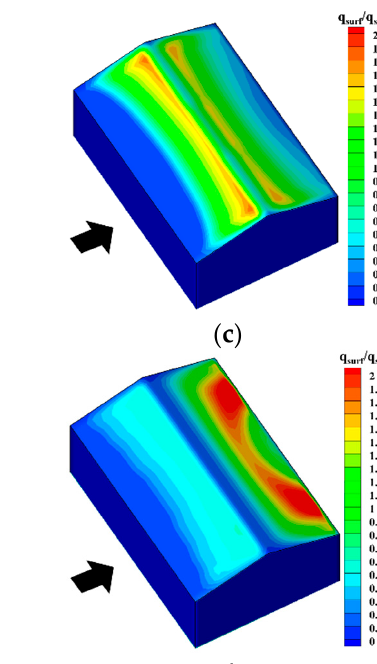
Figure 16. Normalized deposition flux of drifting snow q surf / q sta : ( a ) U H = 2 m/s; ( b ) U H = 3 m/s; ( c ) U H